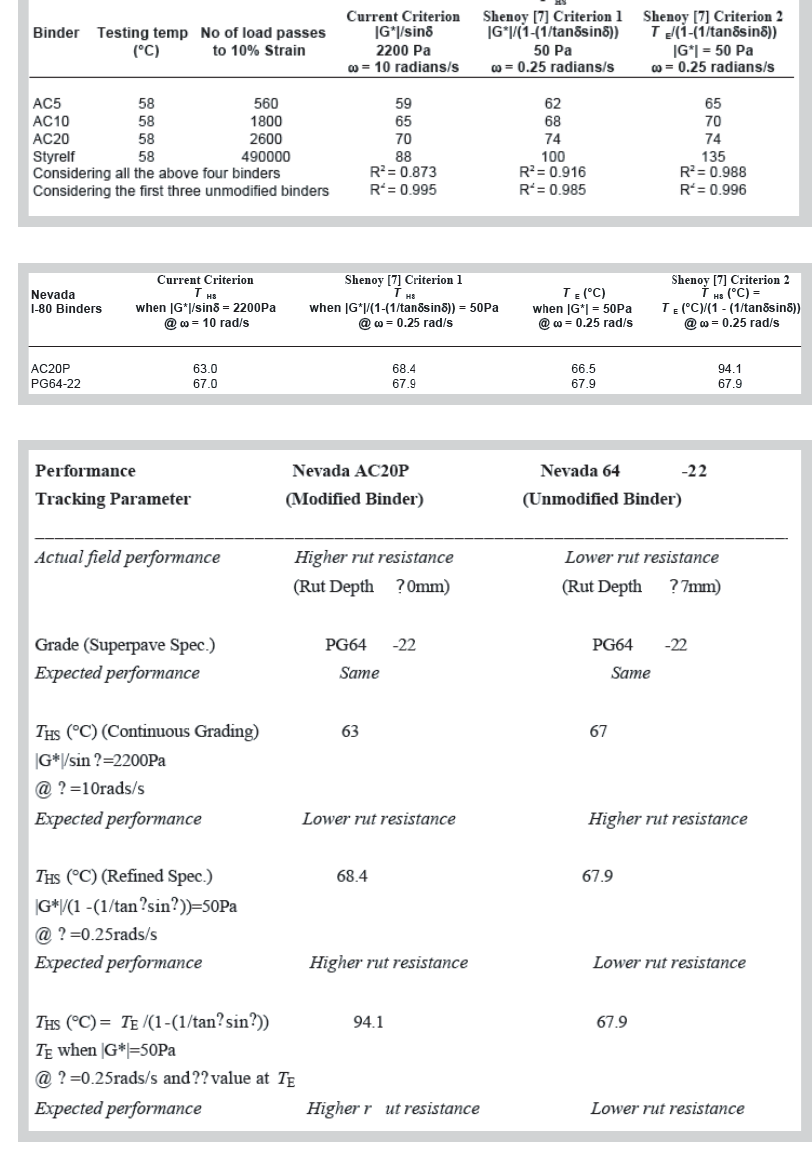
Table 3 (middle): Comparison of the high specification temperature T HS for |G*|/sin d and the two criteria for |G*|/(1-(1 / tan d sin d )) for the binders used in the Nevada I-80 Project. Table 4 (below): Relative performance ranking for the binders used in the Nevada I-80